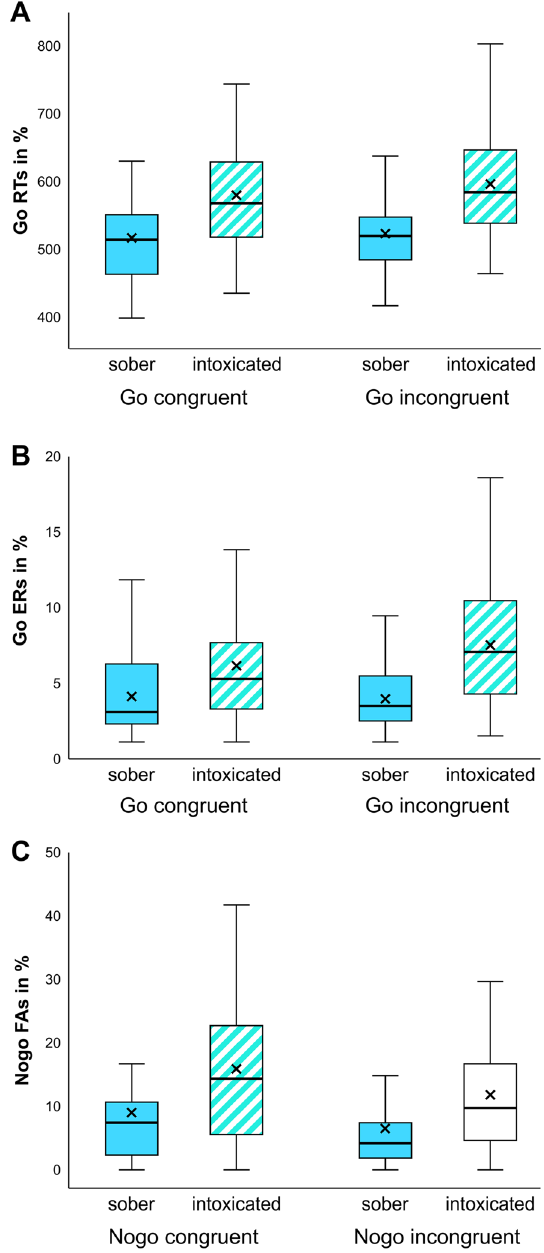
Figure 1. Illustration of the obtained behavioral data. ( A ) The top graph shows Go hit RTs in ms. Of note, the intoxication effect was significantly larger in incongruent than in congruent trials. ( B ) The middle graph shows commission and omission errors/Go error rates in percent. Of note, the intoxication effect was significantly larger in incongruent than in congruent trials. ( C ) The bottom graph shows comission errors/Nogo false alarm rates in percent. Participants performed significantly worse while intoxicated. Effects of appointment order are not